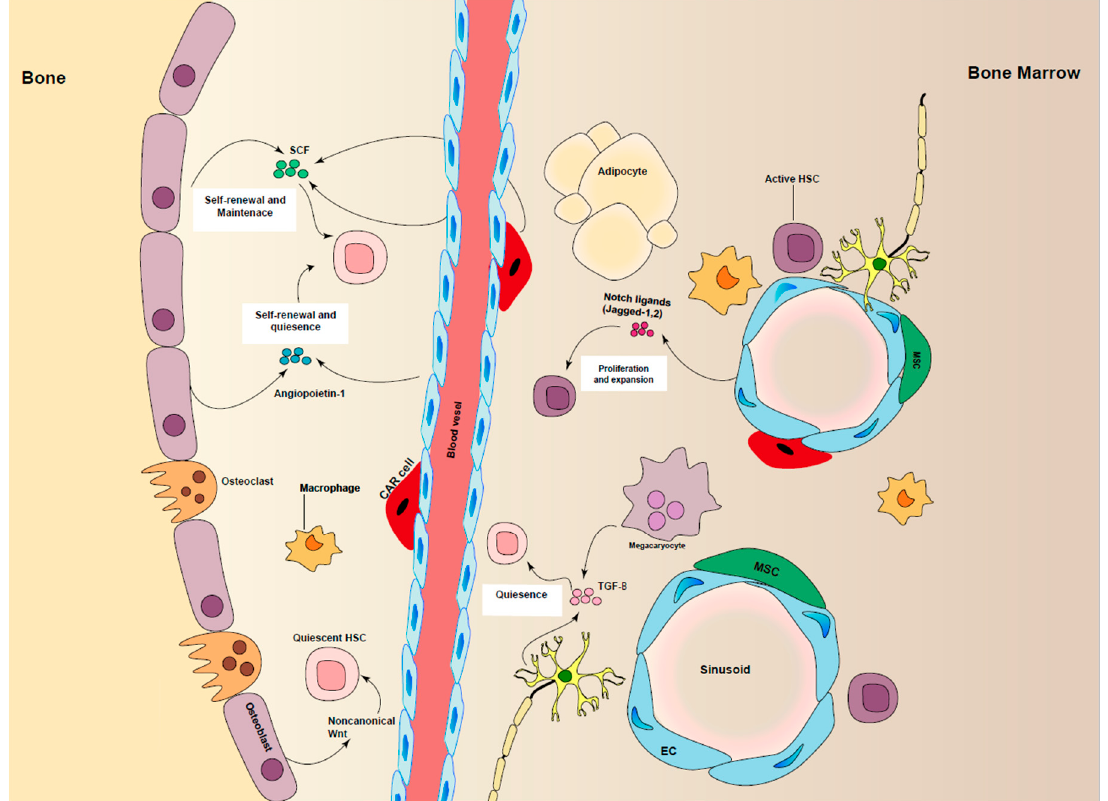
Figure 2. Regulation of HSCs maintenance in niche. Different cell types are involved in promoting HSC maintenance, including perivascular stromal cells, endothelial cells (ECs), macrophages, CAR cells, sympathetic neurons by producing cytokines and growth factors such as stem cell factor (SCF), angiopoietin-1, TGF- β and notch ligands.